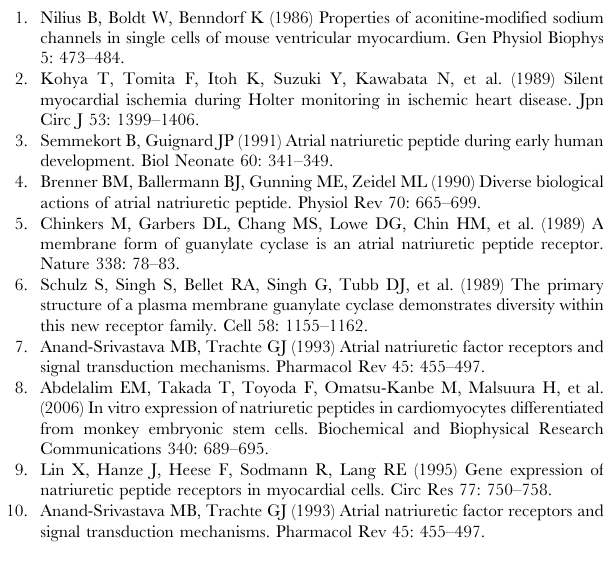
Figure S1 Dose-response and inhibition of ANP on action potentials. A, concentration-response relation between ANP and the decrease in Ca 2 + current. B, action potentials were almost completely inhibited by ANP (20 nM) if washout not followed.